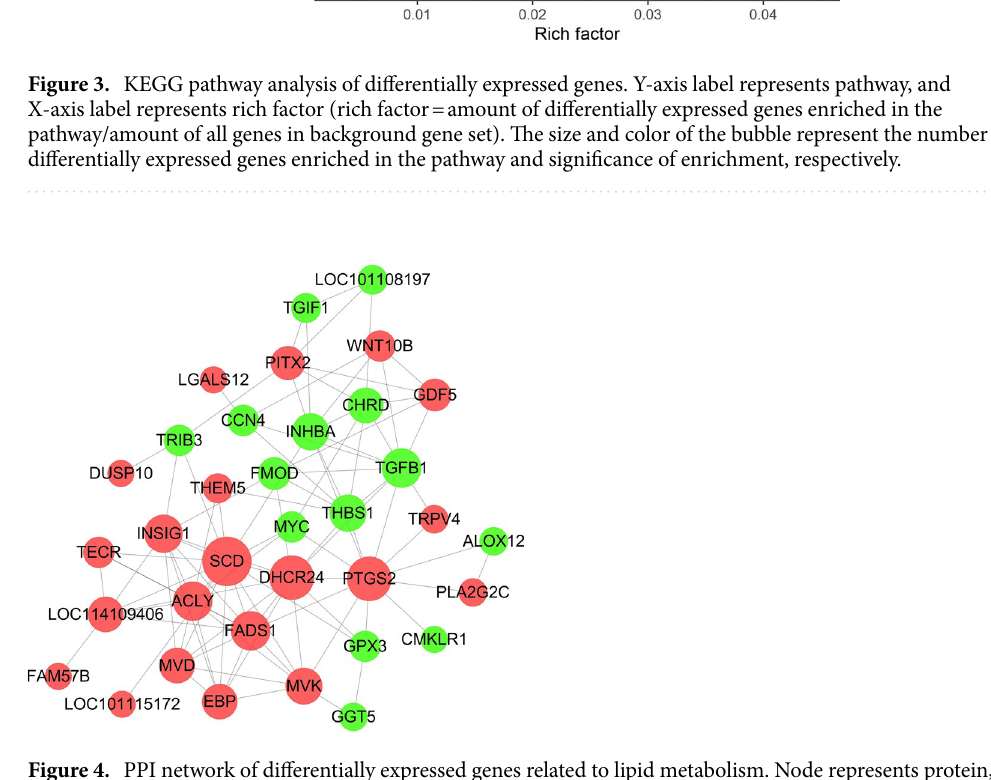
Figure 4. PPI network of differentially expressed genes related to lipid metabolism. Node represents protein, edge represents interaction between proteins. The size of the node is proportional to the degree of the node (the degree of the node is defined as the number of proteins interacting with this node). Red represents the up-regulation of Duolang sheep, and green represents the